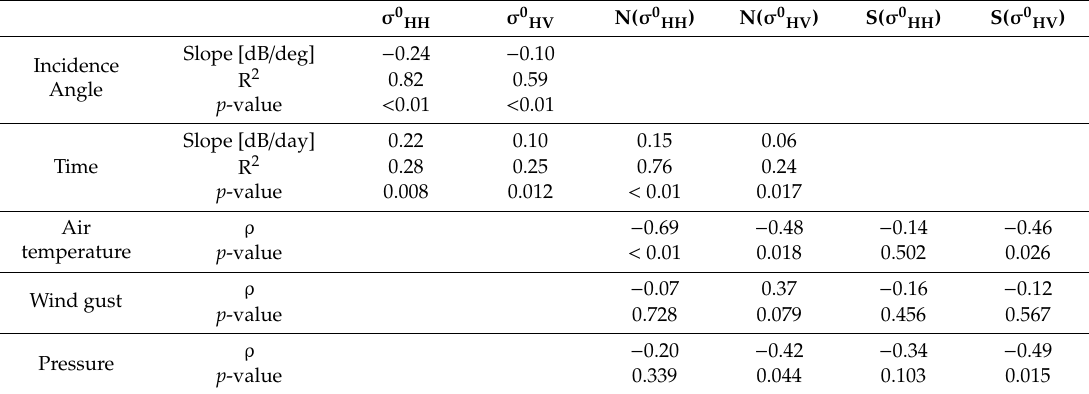
Table 2. The statistical relations, R 2 , the Spearman coe ffi cient ρ , and p -value, for the backscattering coe ffi cients ( σ 0 ), the normalized backscattering coe ffi cients (N( σ 0 )), and the spatial standard deviations (S( σ 0 )), in both polarizations with the atmospheric variables. σ 0